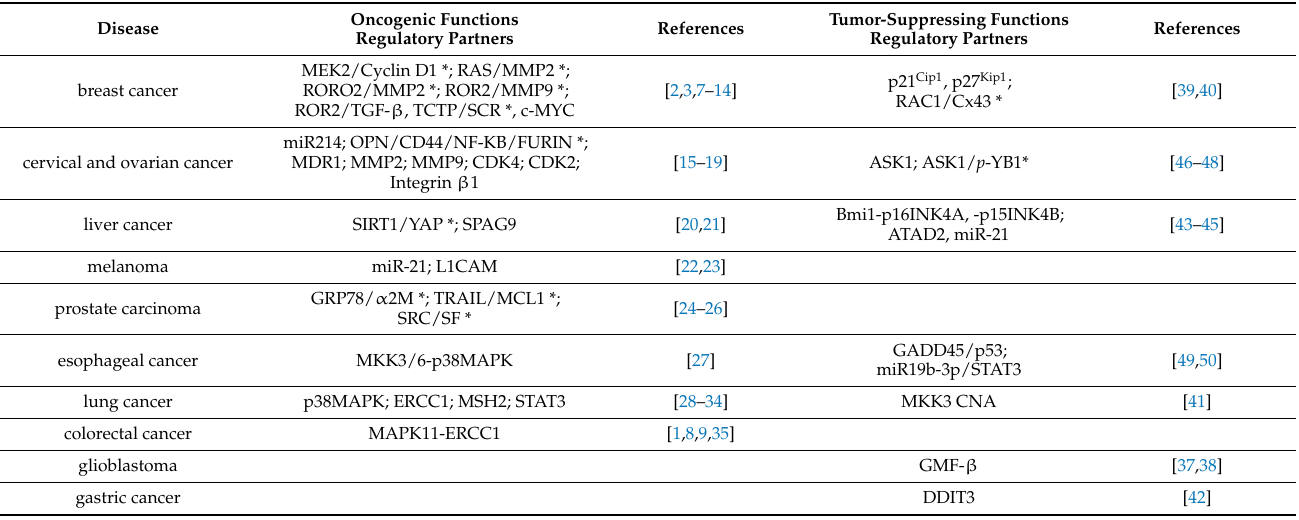
Table 1. Pathologies with reported MKK3 oncogenic and tumor-suppressing functions and regulatory partner